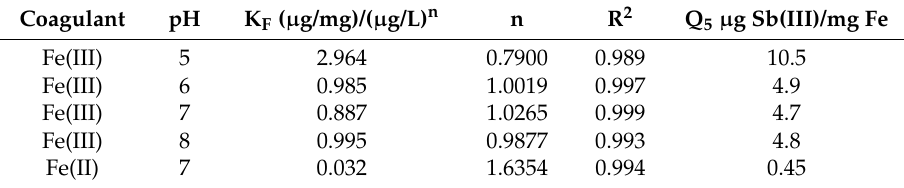
Table 2. Freundlich fitting parameters for the Sb(III) adsorption isotherms (Q = K F C n ).